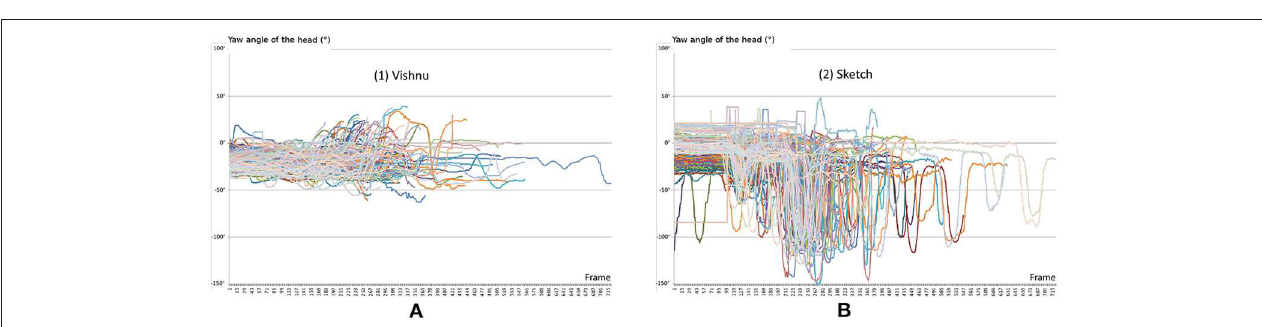
FIGURE 5 | (A) A subject performing the pilot user study in mode 1 with the first target layout (L1). Notice the setup used for each mode: the transparent video HMD is used in mode 1, and in mode 2, the desktop screen on the side of the workspace is used to display sketches made by the expert, which are overlaid on the video stream of the camera. The virtual target spaces are reproduced from the real agent’s workspace, as used in the expert’s VE: (B) : first layout (L1); (C) : second layout (L2).